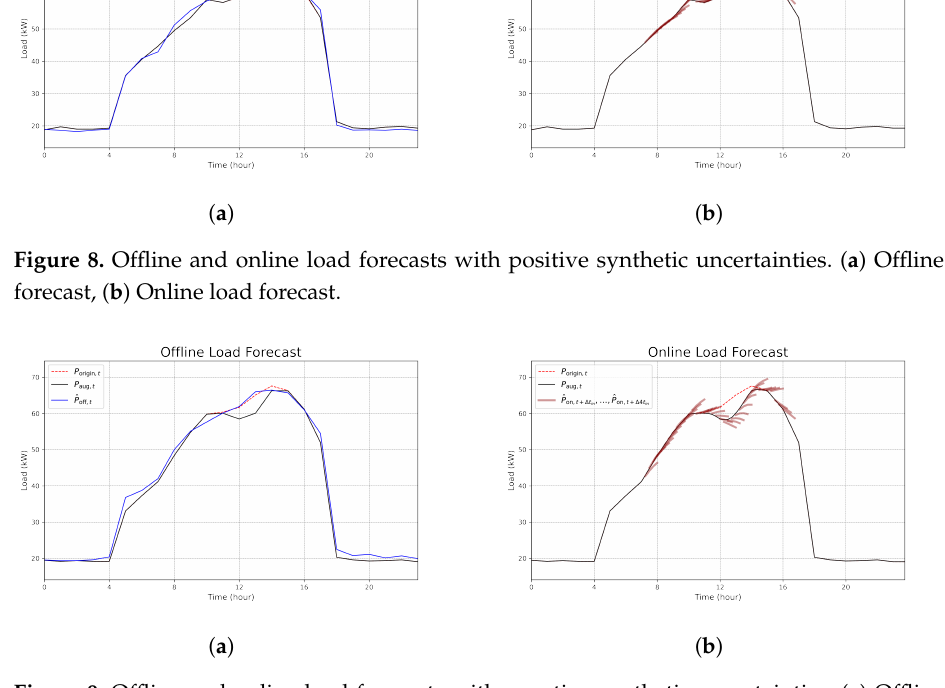
Figure 9. Offline and online load forecasts with negative synthetic uncertainties. ( a ) Offline load forecast, ( b ) Online load